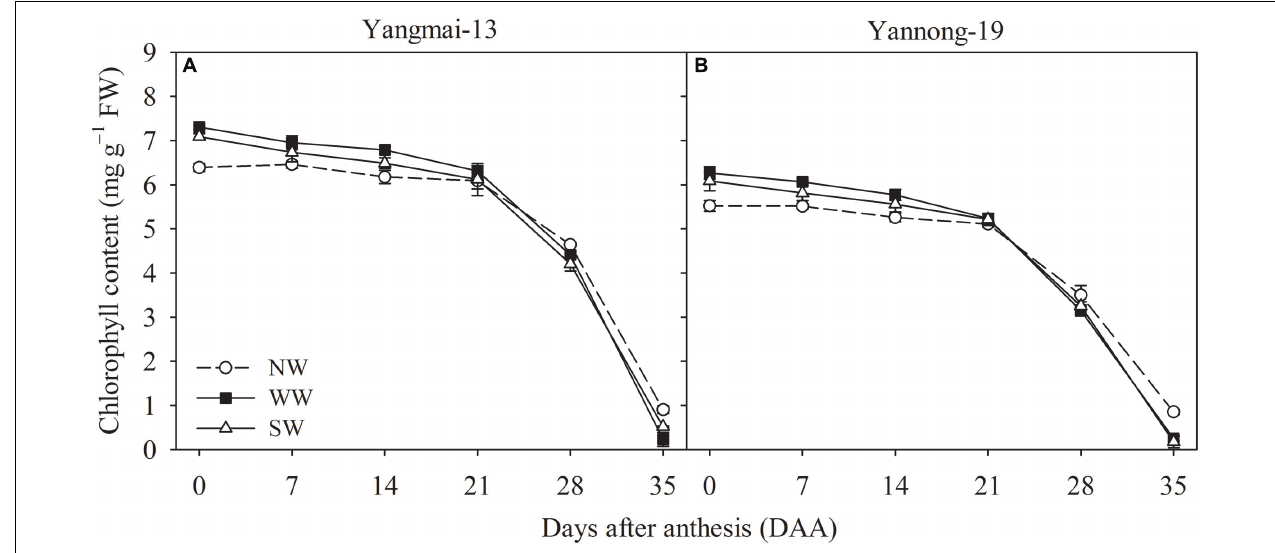
FIGURE 3 | Chlorophyll content as affected by winter (WW) and spring (SW) night-warming in the flag leaves of Yangmai-13 (A) and Yannong-19 (B) after anthesis during 2013–2014. NW refers to the no warming control. The data are the means ± SE ( n = 3).